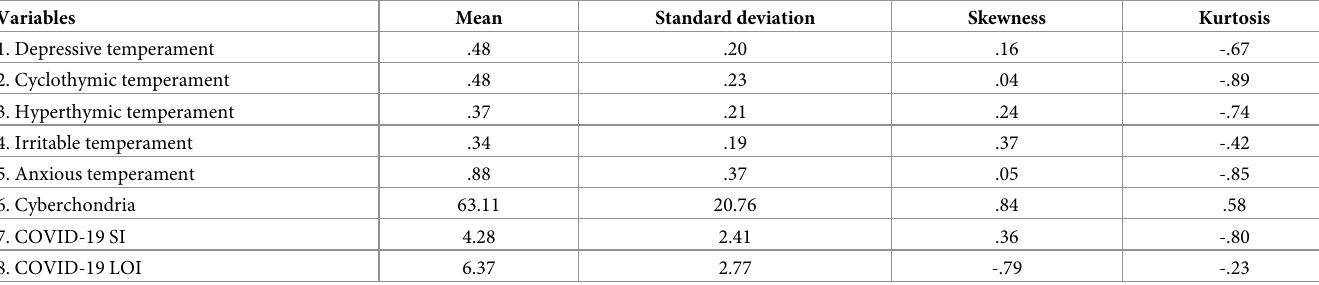
Table 2 provides descriptive statistics, including skewness and kurtosis values, for analysed variables. All the data analysed in the study reached the criterion of compliance with the nor- mal distribution. Table 3 presents the Pearson r correlation coefficients between analysed variables in the studied group.